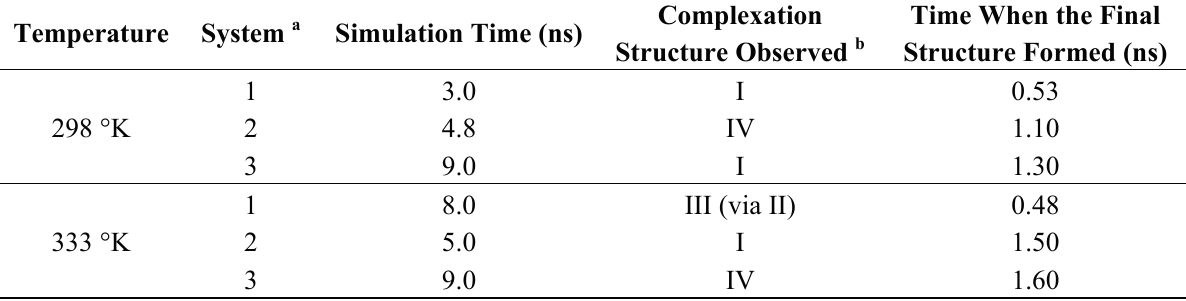
Table 1. Molecular dynamics simulations for the CCB/HP- β -CD